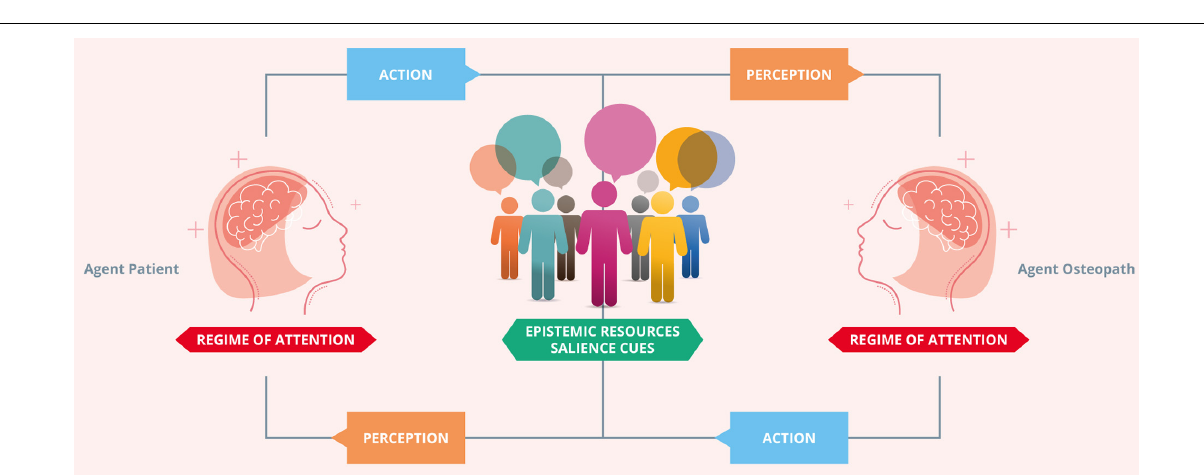
Frontiers in Psychology |